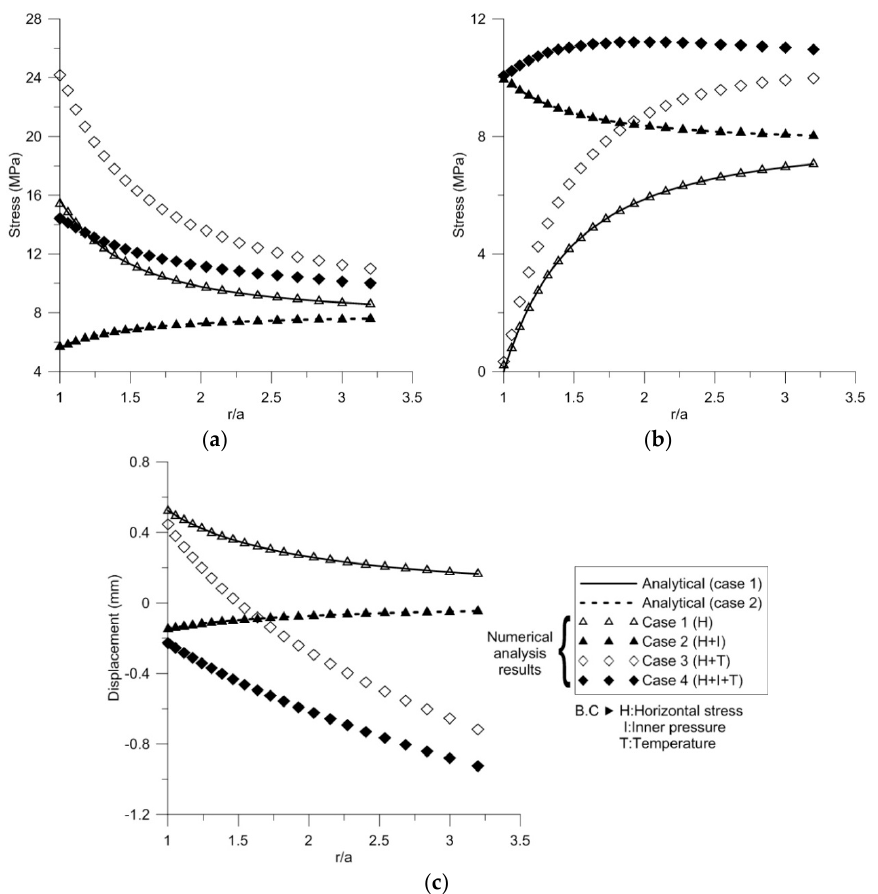
Figure 3. Comparison of ( a ) Tangential stress σ θ , ( b ) Radial stress σ r and ( c ) Radial displacement u r .